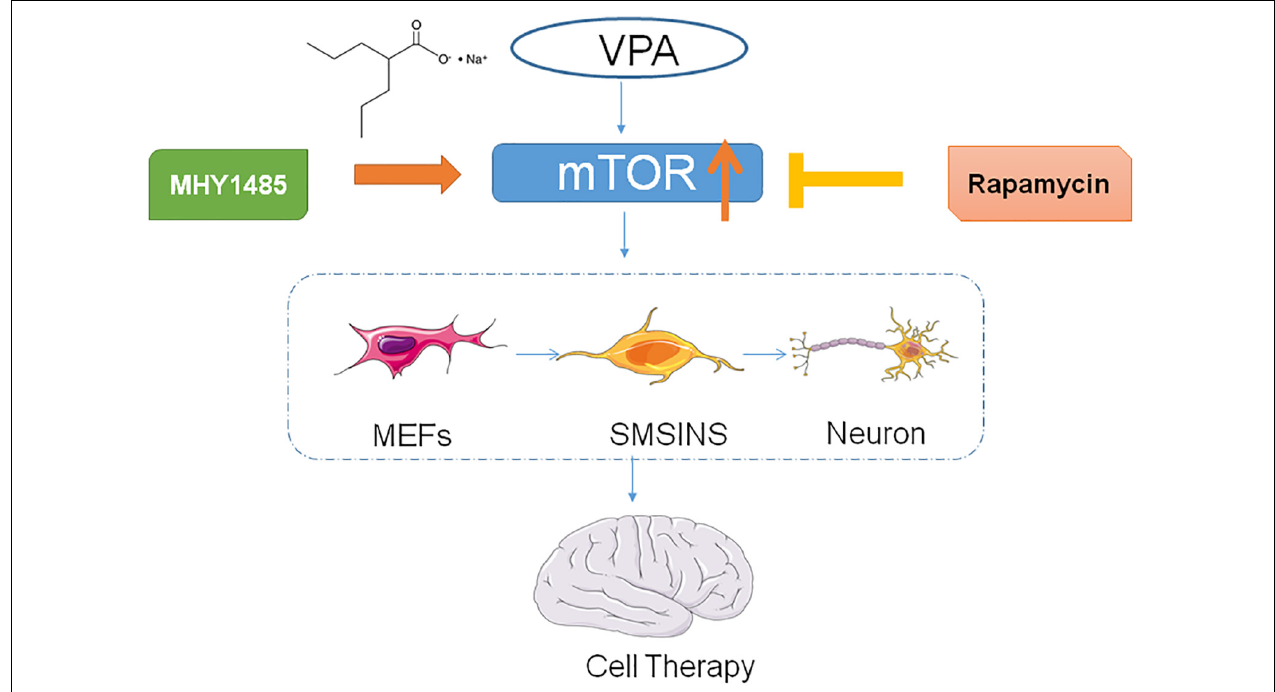
FIGURE 8 | Table of contents